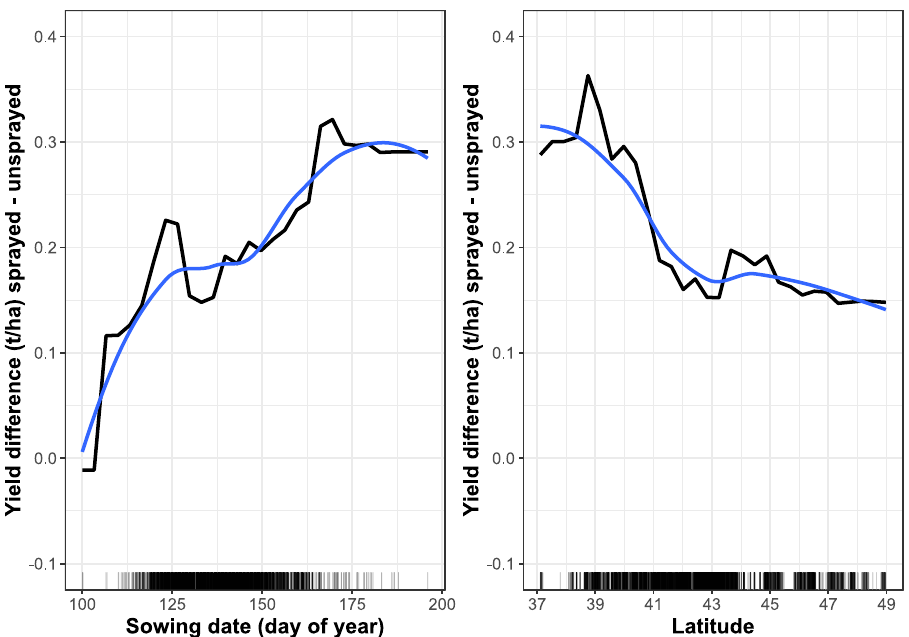
Figure 2. Two-way partial dependence plots of the global effects of (i) foliar fungicide use and sowing date (left panel), and (ii) foliar fungicide use and latitude (right panel) on soybean yield. The black plotted curves are the yield differences between fields that were sprayed or not sprayed with foliar fungicides. Smoothed versions of the curves are shown in